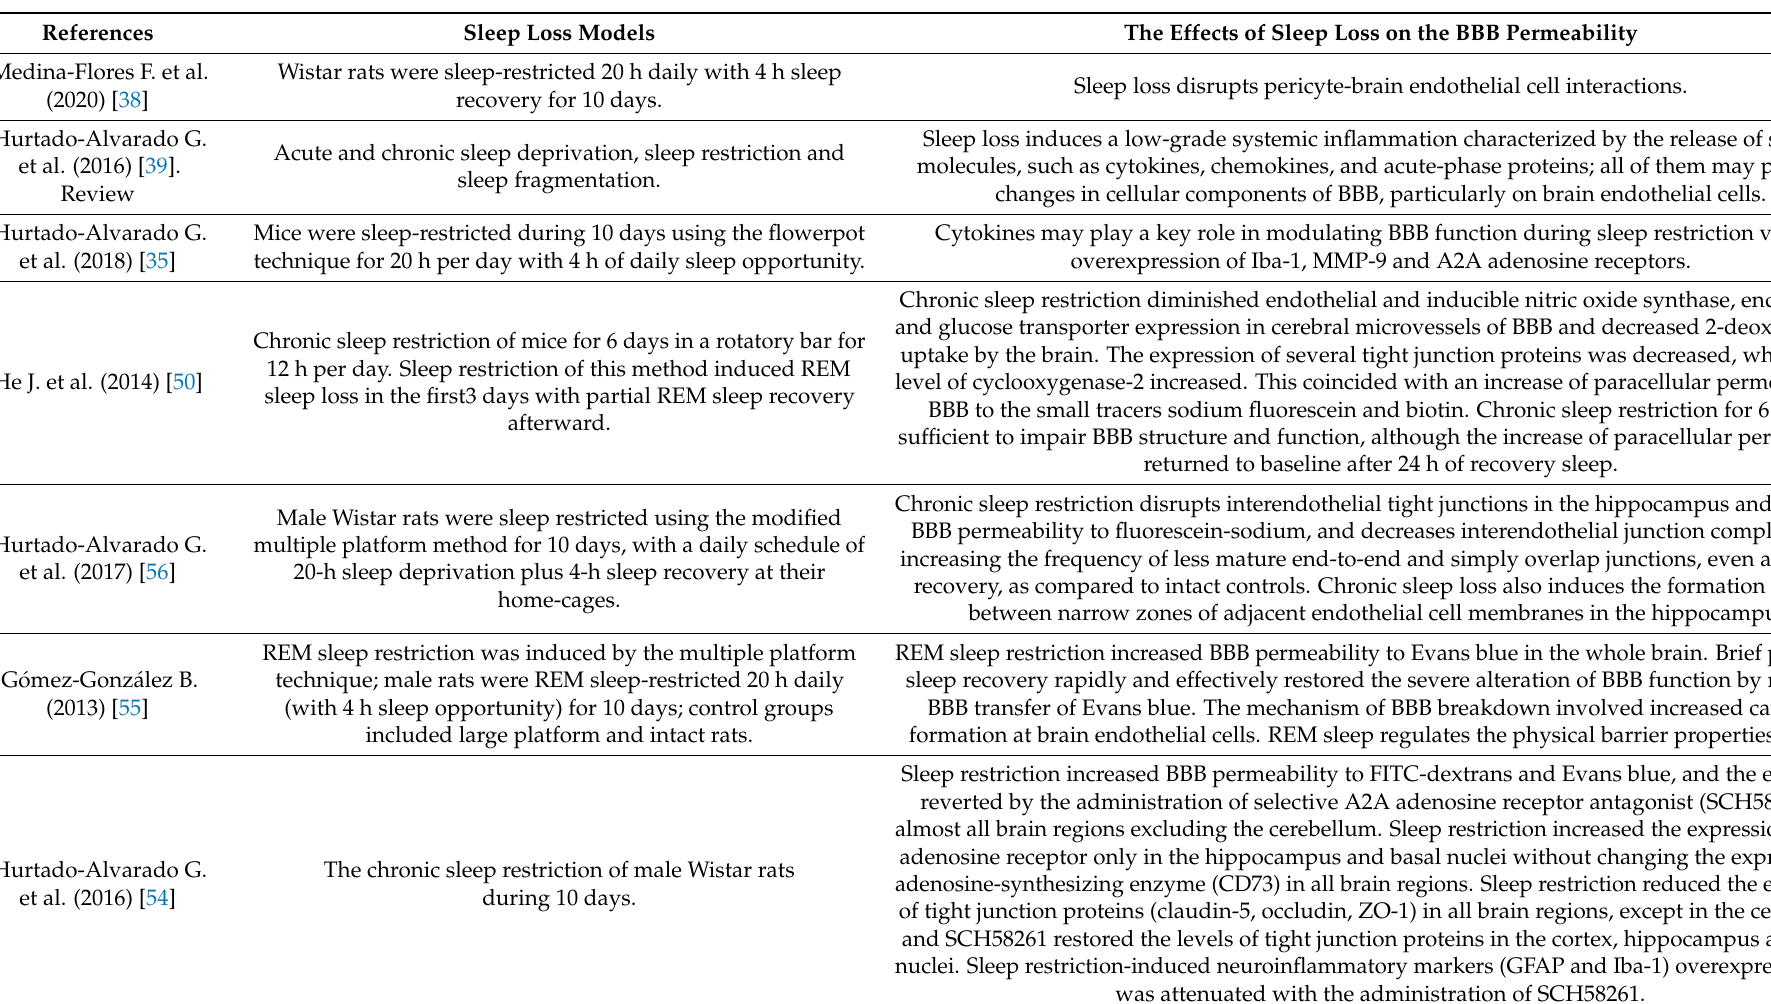
Table 1. The effects of sleep deprivation on the blood–brain barrier